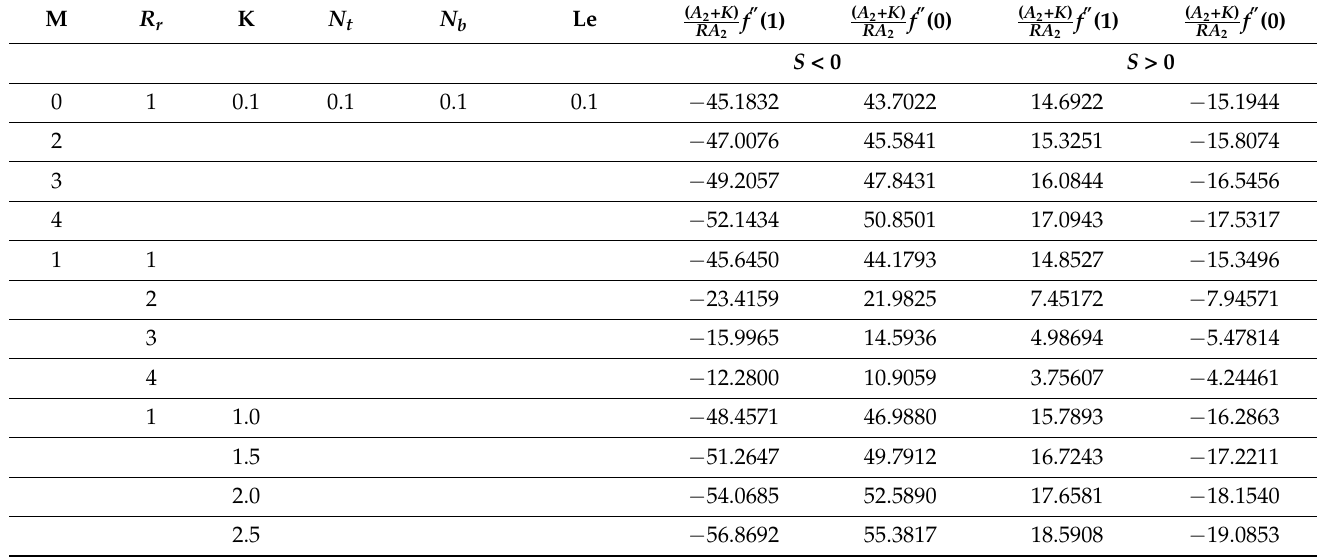
Table 2. Skin friction coefficient for γ Al 2 O 3 − H 2 O at lower and upper plane with strong interaction n = 0.